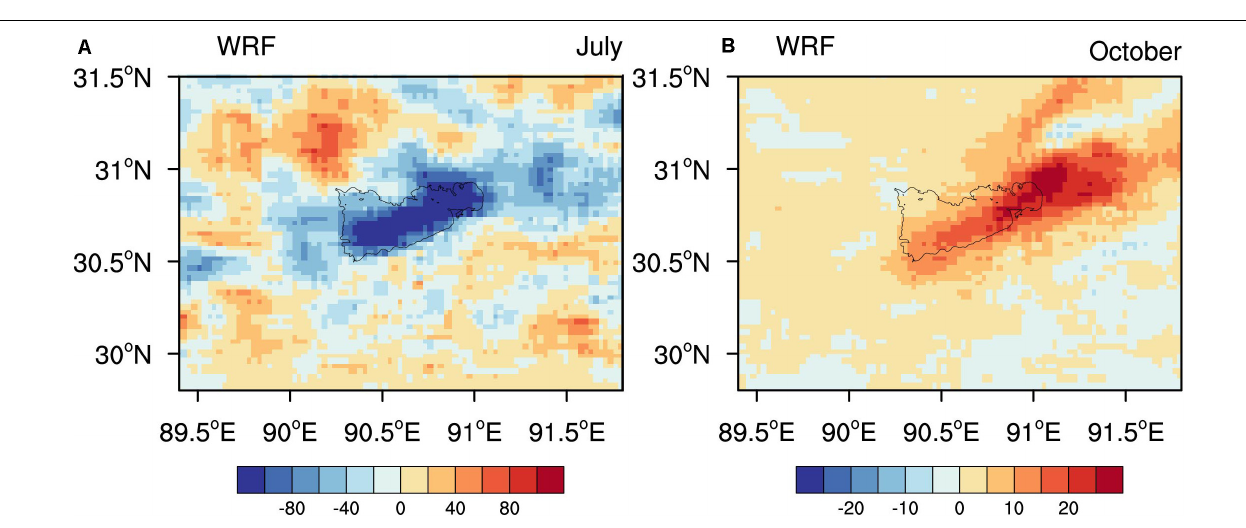
Frontiers in Earth Science |